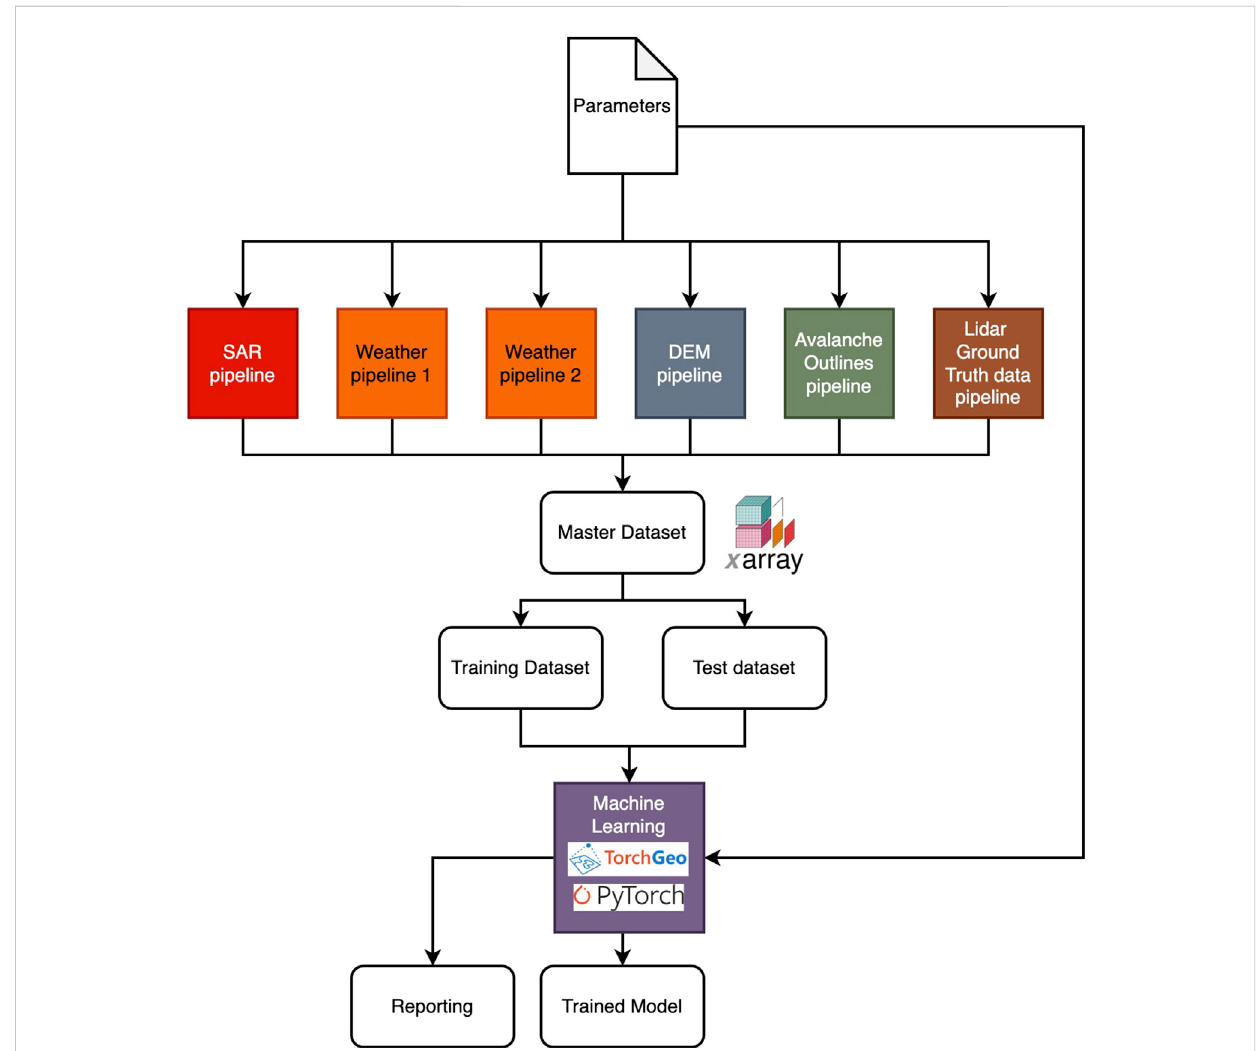
FIGURE 3 High level overview of the data pipeline, controlled by a set of parameters and orchestrated by Kedro. “ DEM ” stands for digital elevation model. Where the ML algorithms are implemented in PyTorch with TorchGeo (Stewart et al.,